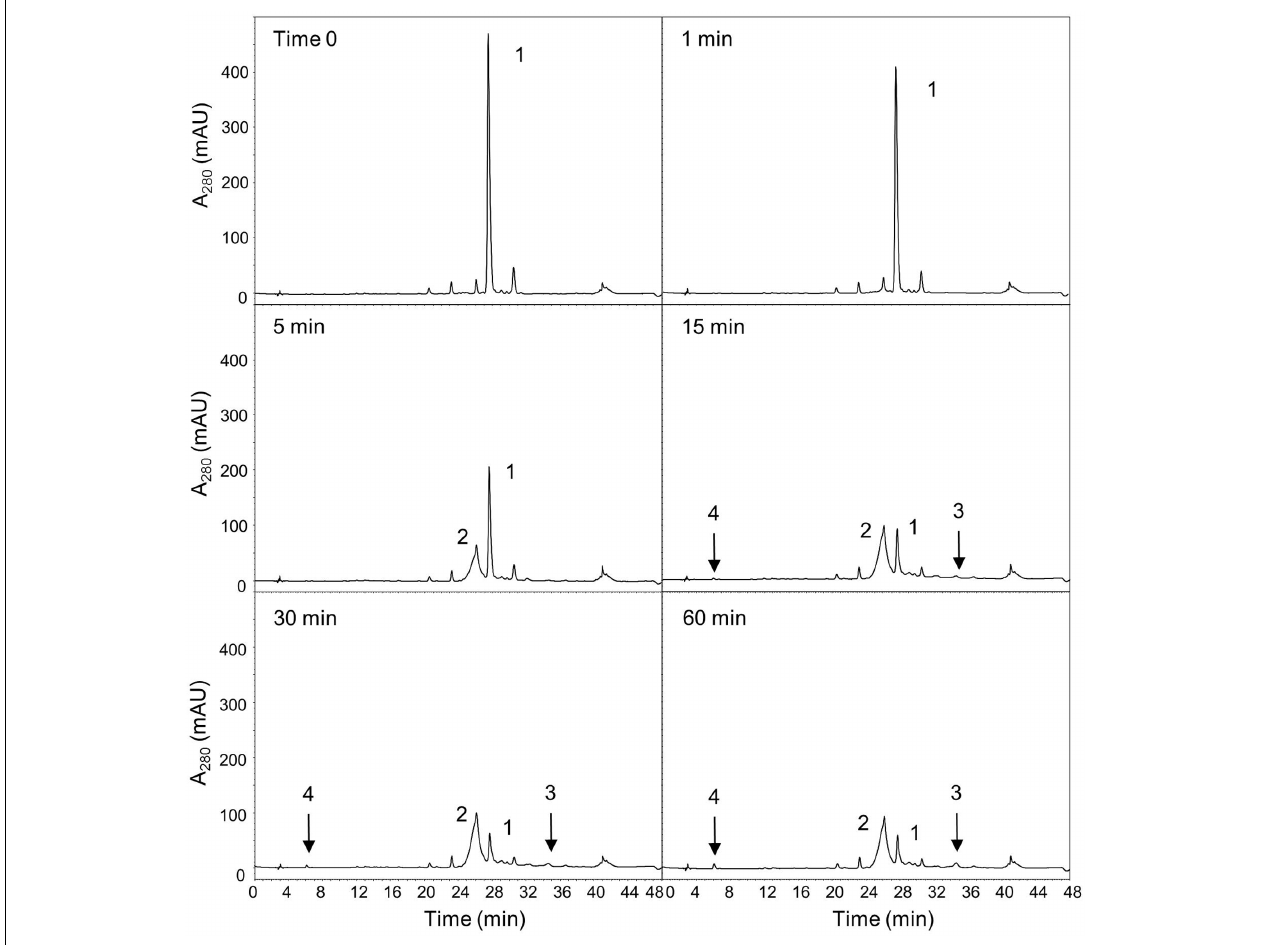
FIGURE 2 | Time-course of the oleuropein hydrolysis catalyzed by the purified recombinant OepGLU. Enzyme activity was assayed as indicated in Material and Methods. Identification of peaks: 1, oleuropein; 2, OA-isomers; 3, 3,4-DHPEA-EA; 4,